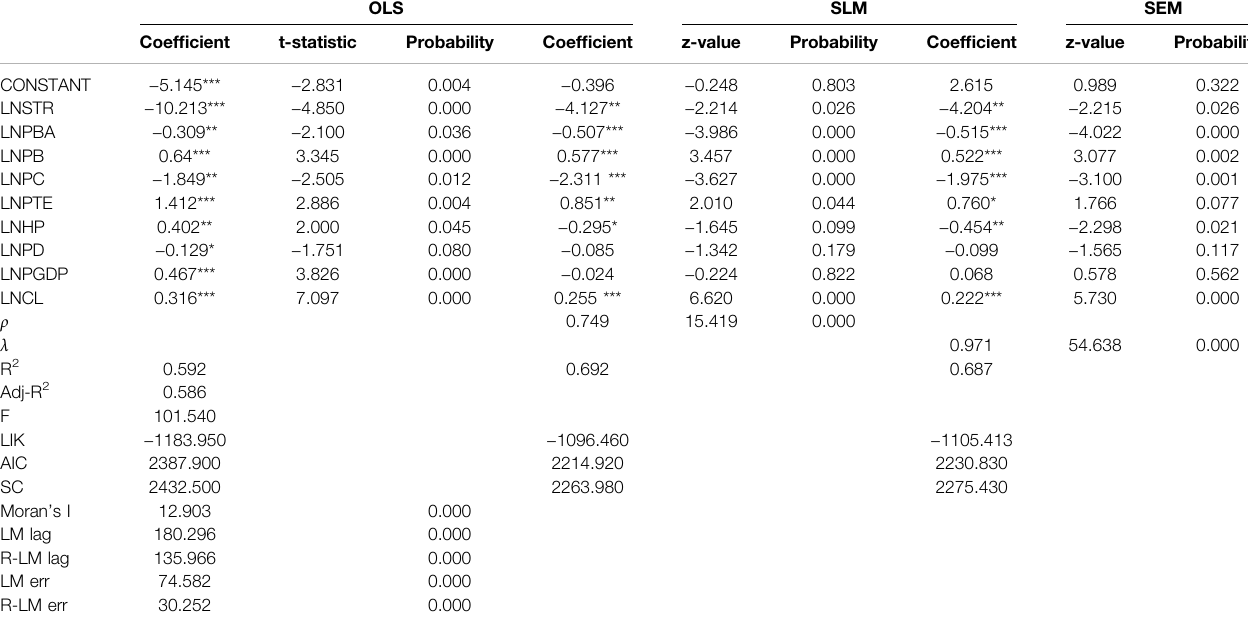
TABLE 3 | Regression results of the spatial econometric